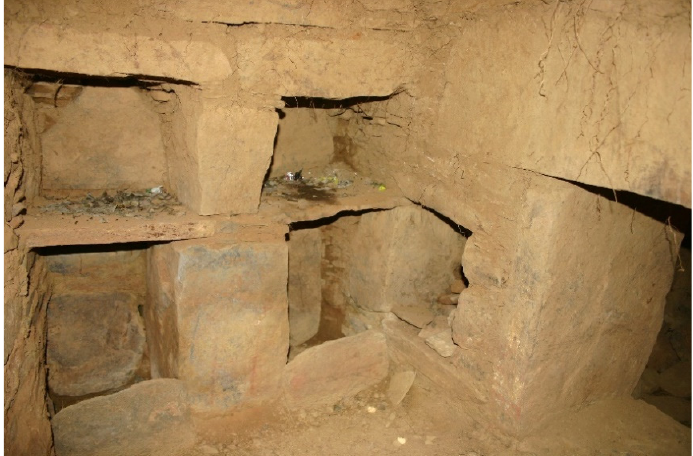
Figure 6. Interior of a chullpa structure, near Roko Amá, showing built-in compartments for the storage of special ritual objects and paraphernalia. Today, they contain offerings made to the building’s spirits, in the form of coca leaves, sweets, and sacrifices of guinea pigs. Photograph by